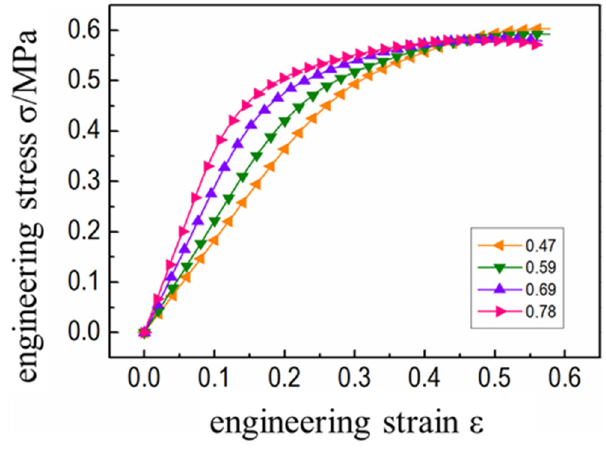
Figure 4. Stress-strain curves of propellants with different volume fractions.